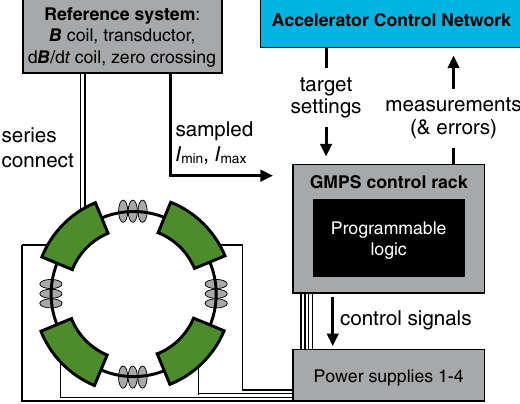
FIG. 1. Schematic view of the GMPS control environment. The human operator specifies a target program via the Accelerator Control Network that is transmitted to the GMPS control board.